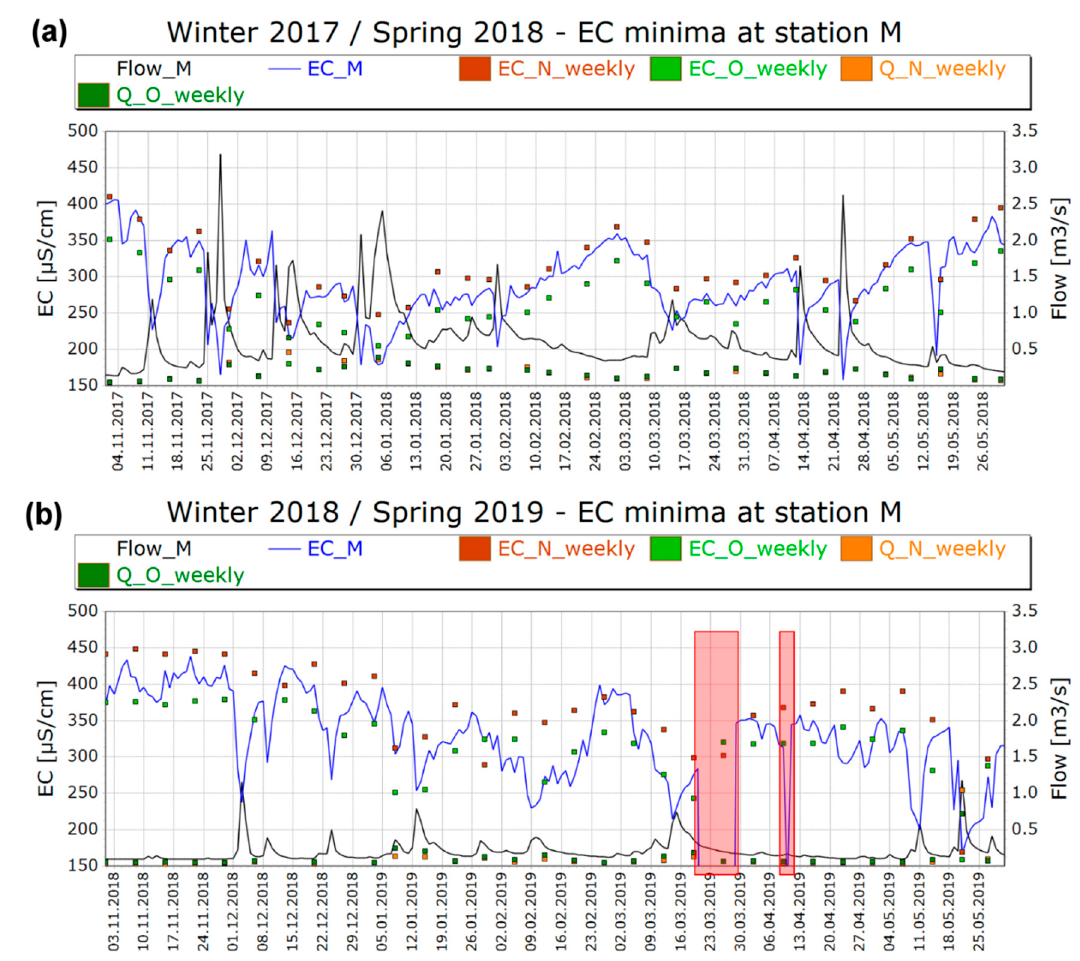
Figure 12. Estimation of EC runoff during winter/spring ( a ) 2017/2018 and ( b ) 2018/2019 at station M. Periods with missing data are marked by red boxes and excluded from evaluation. Daily mean flow data acquired from the HLNUG [33].